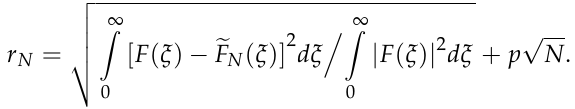
Figure 2. Dependence of the approximated function F ( ξ ) and approximating functions (cid:101) F N ( ξ )